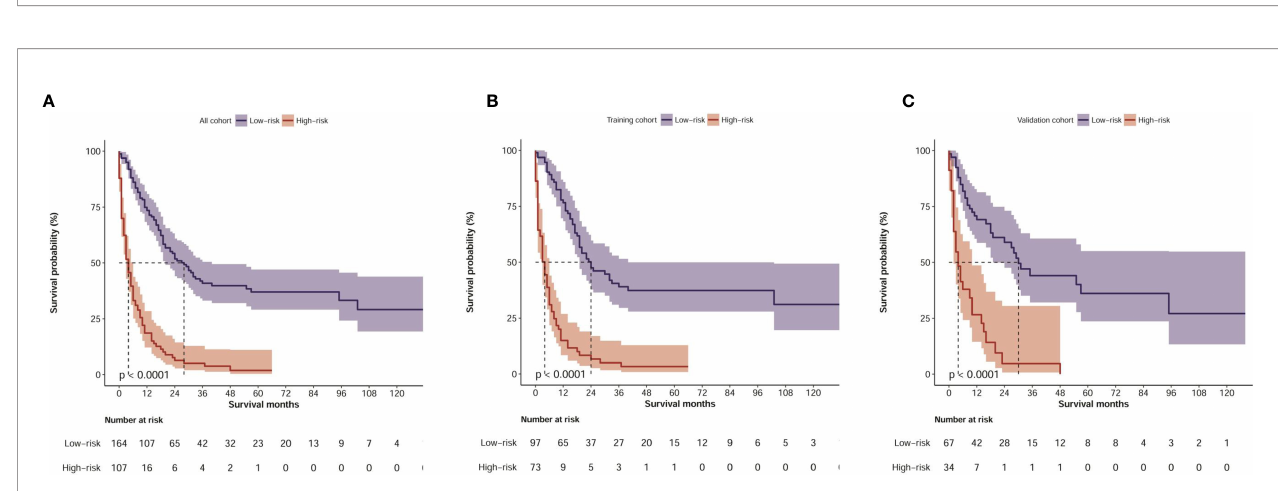
FIGURE 4 | Kaplan – Meier curves of OS for risk classi fi cation based on the nomogram scores. (A) In all cohort; (B) In the training cohort; (C) In the validation